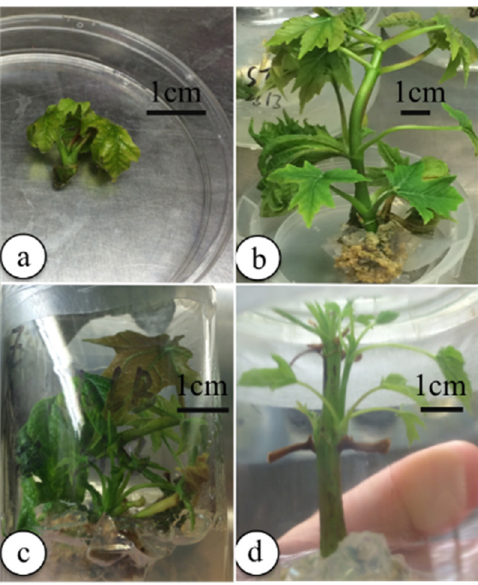
Figure 1. Results from initial experiments to induce shoot growth in bigleaf maple on DKW medium. BA (2.2 µ M)—induced bud ( a ). Shoot grown on medium supplemented with 10 µ M zeatin and 0.01 µ M TDZ ( b ). A shoot cultured on 27 µ M zeatin produced a large callus base with multiple petioles and no additional shoots ( c ). Example of rare axillary shoot proliferation in the absence of shoot tip removal, on media containing 10 µ M and 0.01 µ M TDZ zeatin ( d ).